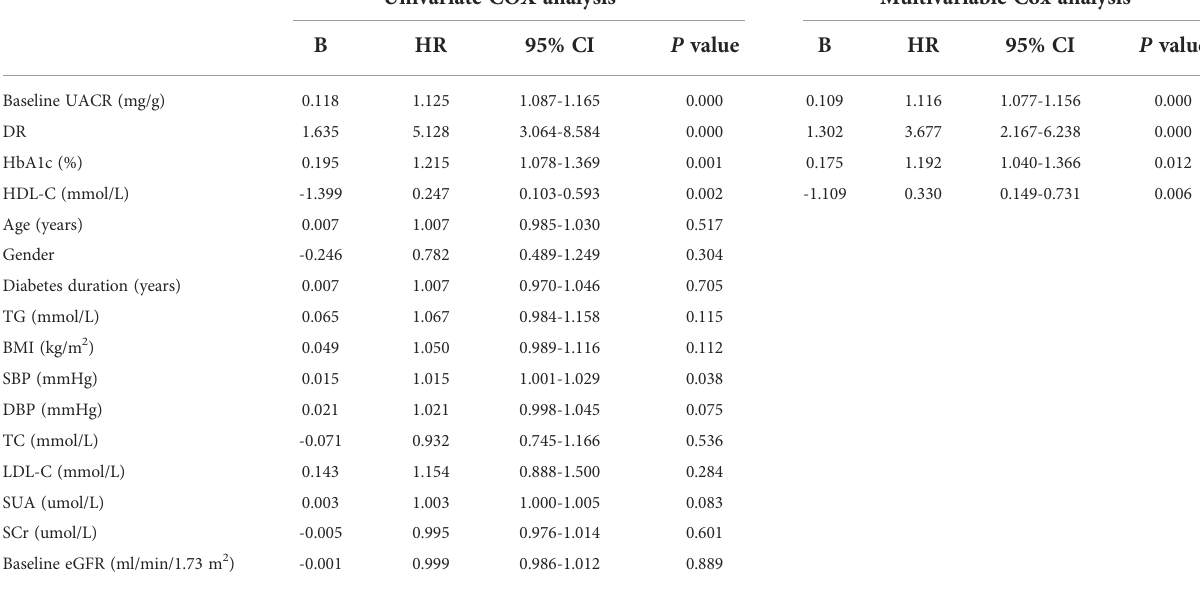
TABLE 6 Univariate and multivariable Cox analysis for the risk factors of DKD.